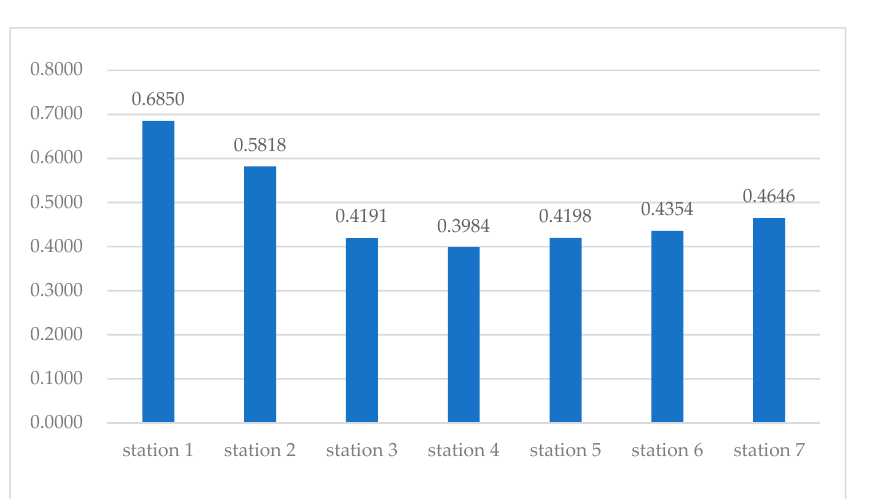
Figure 5. Evaluation values of charging stations.